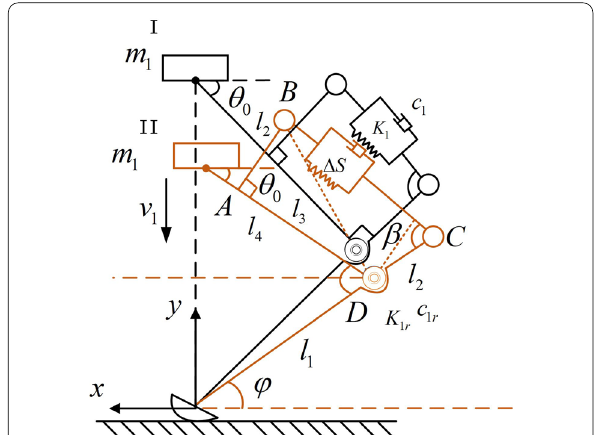
Figure 15 Tension process for the first-stage buffer